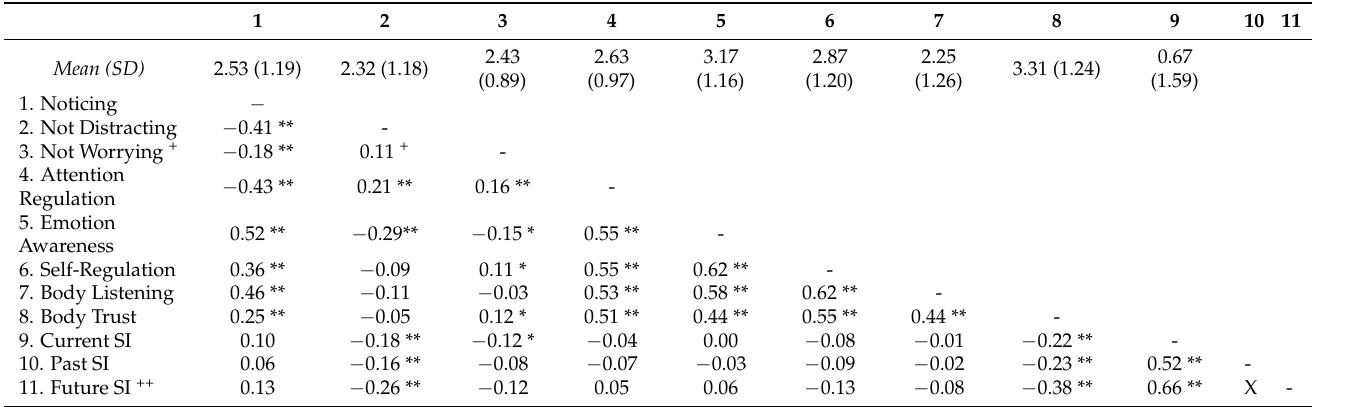
Table 1. Zero-order correlations for all MAIA subscales and current, past, and future likelihood of suicidal ideation symptoms in Study